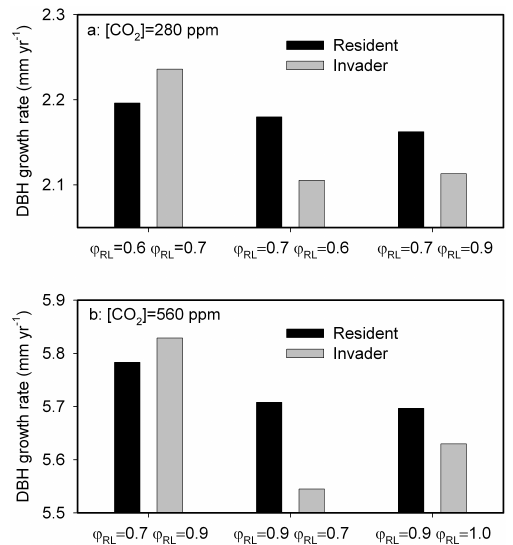
Figure 9. DBH growth rates of residents and invaders in pairwise invasion simulations. This figure shows DBH growth rates in pair- wise competition experiments at (a) preindustrial [CO 2 ] (280ppm) and (b) doubled [CO 2 ] (560ppm) for residents (black bars) and invaders (gray bars) that differed only in their fine-root allocation ( ϕ RL ; see Fig. 8 legend for explanation). In each experiment, the resident type was simulated for 400 years in monoculture, and then a small fraction of its density was converted to the invading type. The competitive optimum ( ϕ RL = 0.7 and ϕ RL = 0.9 at 280 and 560ppm, respectively) is the type ( ϕ RL ) that cannot be invaded and can invade all other types (i.e., the convergence-stable evolutionar- ily stable strategy,